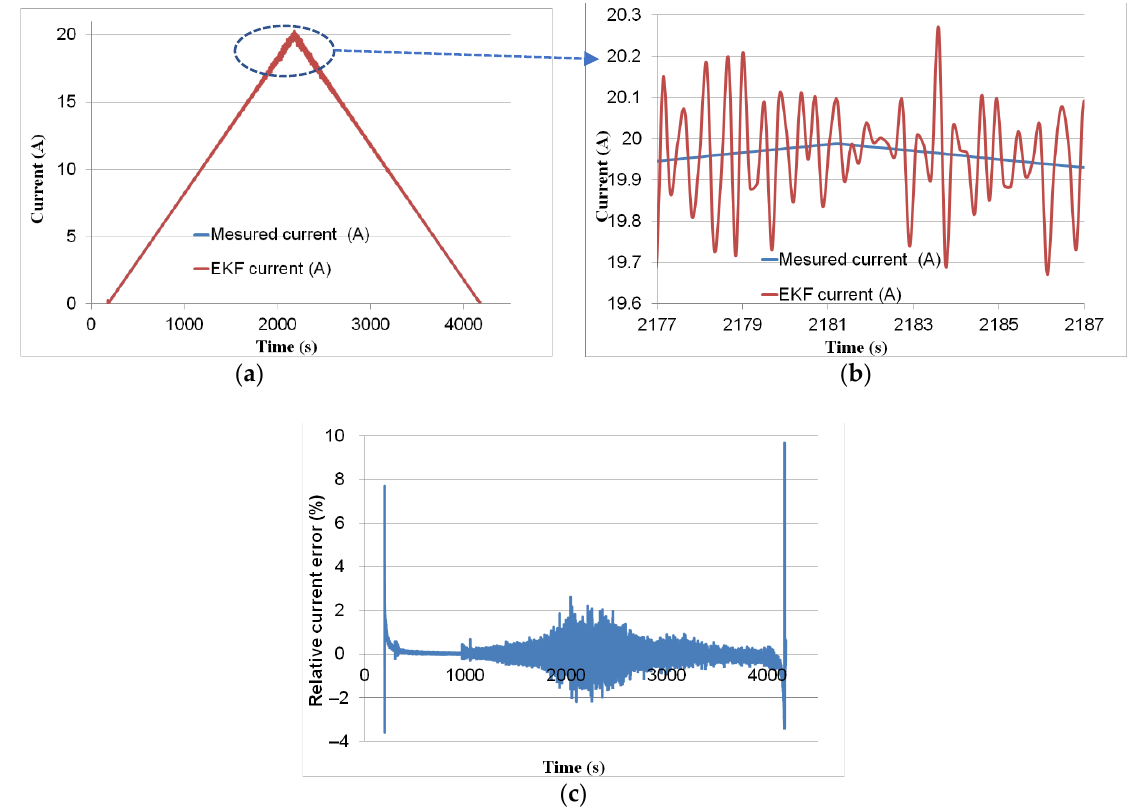
Figure 8. ( a ) Measured current and current estimated by EKF. ( b ) Zoomed-in image of both curves between 2177 and 2187 s. ( c ) Relative error of estimated current.